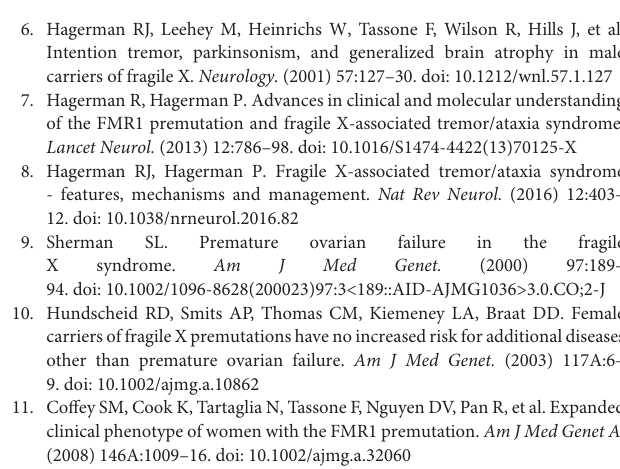
Supplementary Table 1 | Reported frequencies of each comorbid condition. Supplementary Table 2 | Prediction models for each comorbid condition. Supplementary Table 3 | Prediction model p -values using GEE analysis to adjust for relatedness of individuals (see Methods) within the dataset for models presented in Table 2 . Supplementary Table 4 | Prediction model p -values using GEE analysis to adjust for relatedness of individuals (see Methods) within the dataset for models presented in Supplementary Table 2